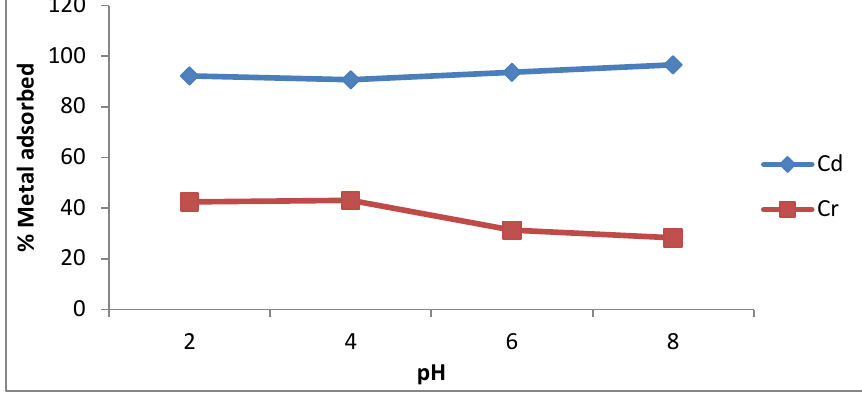
Figure 2: Effect of pH on the removal of metal ions from aqueous solution